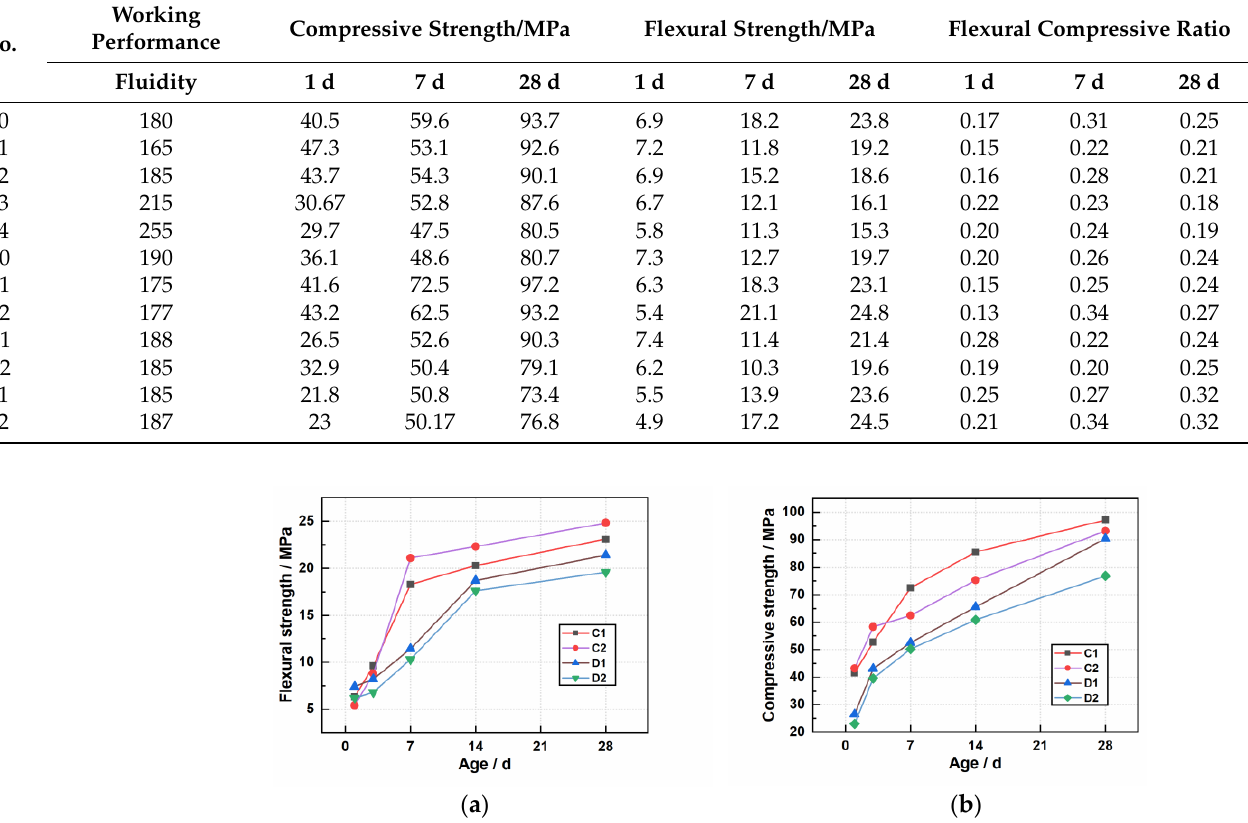
Table 9. Performance data of UHP-ECC.